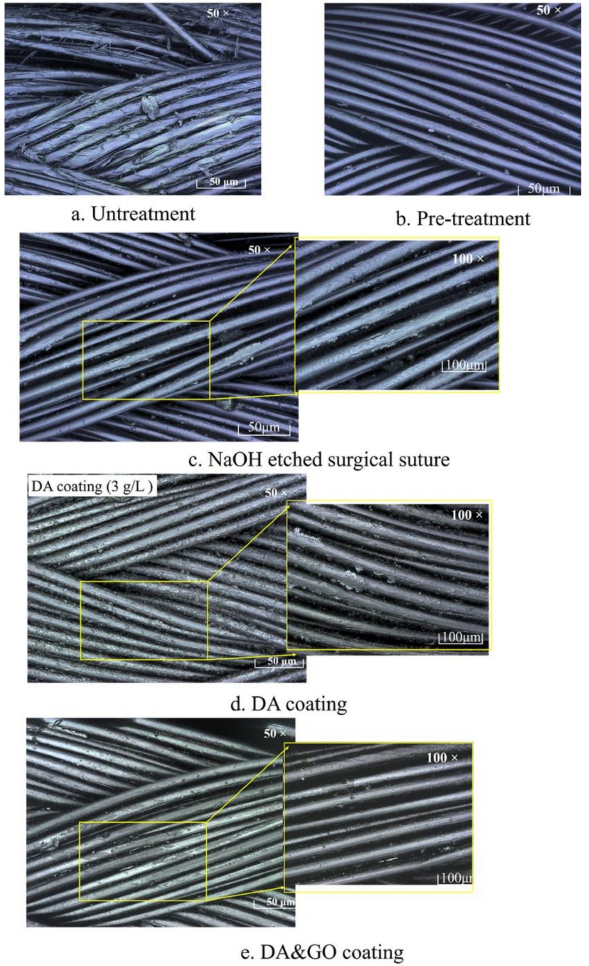
Figure 5. Morphology of the surface of the surgical sutures with di ff erent treatments. ( a ) Untreated suture; ( b ) THF treatment; ( c ) NaOH-etched suture; ( d ) DA coating; ( e ) DA and GO